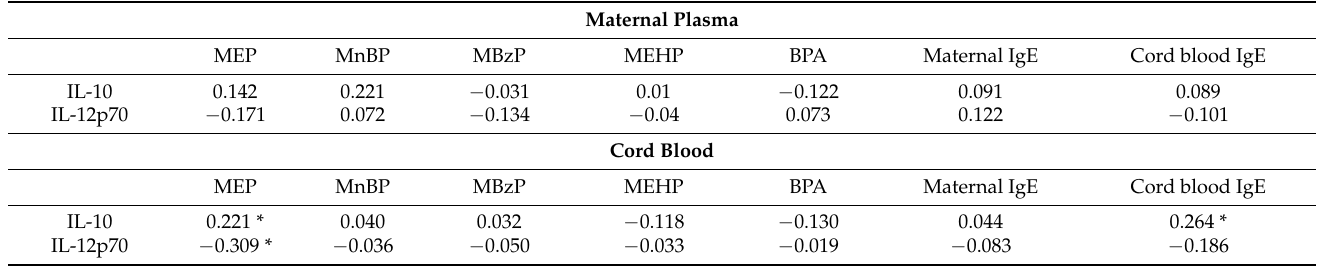
Table 5. Spearman correlation among maternal urinary phthalate metabolites, maternal plasma cytokines, and cord blood plasma cytokines level.